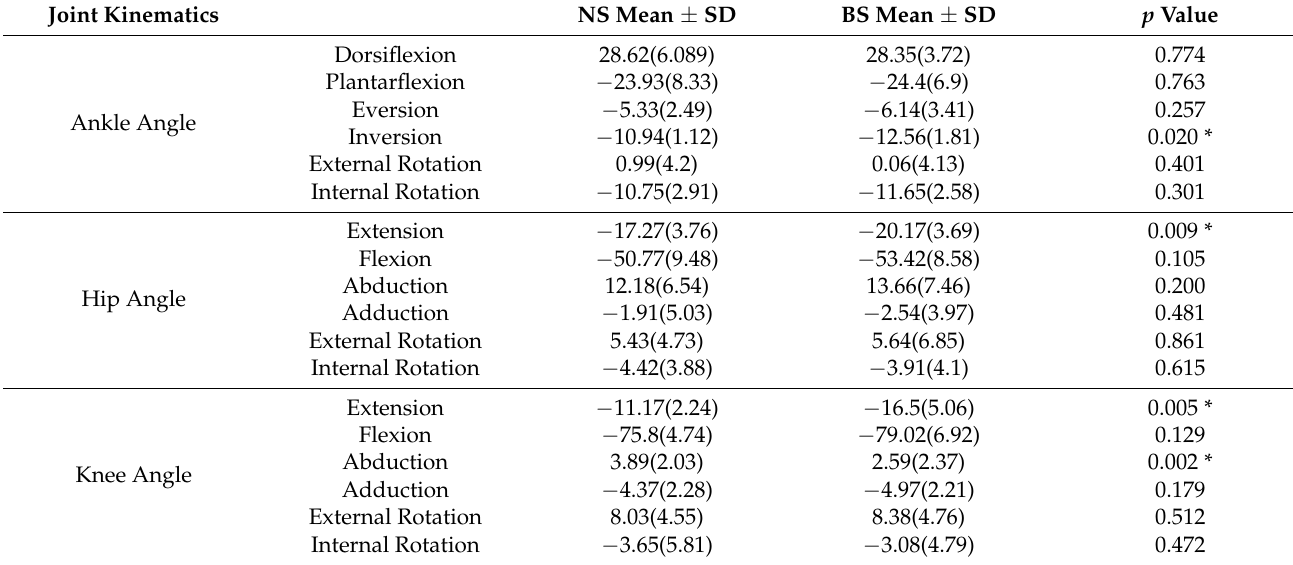
Table 1. Comparison of all kinematic variables between NS and BS during the SLL phase when jumping from 40 cm heights. Joint Kinematics